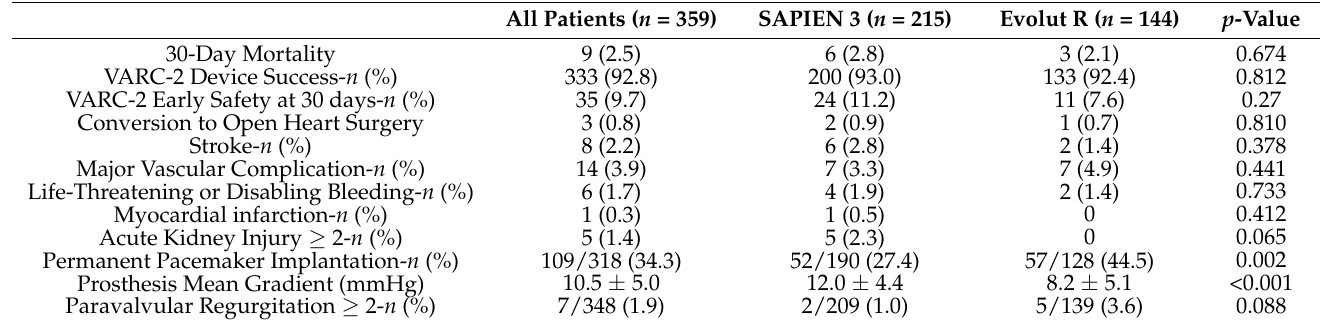
Table 3. Peri- and Post-procedural